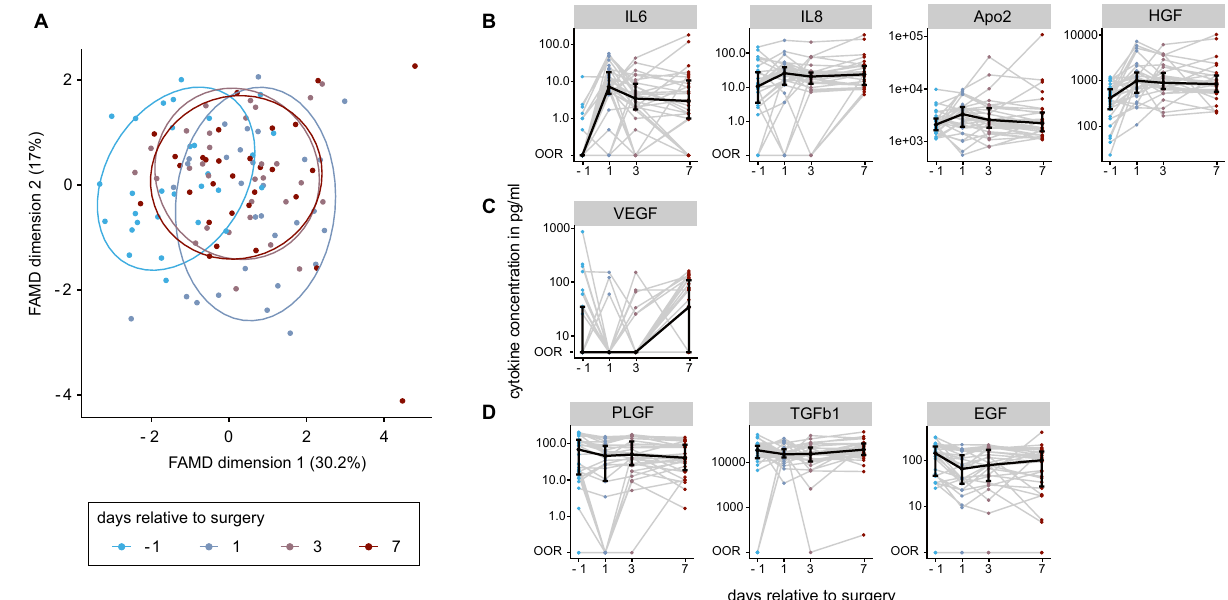
Figure 2. Cytokine and growth factor levels vary before and after surgery. ( A ) Factor analysis for mixed data on cytokine and growth factor data. The first dimension explains 30.2% of the variance and separates preoperative time point (day -1) from postoperative time points. 80% confidence intervals are drawn per time point. Every point represents one patient for one time point. ( B ) Time course of cytokines and growth factors relative to surgery showing increasing concentrations. ( C ) Time course of VEGF showing concentrations below the detection limit until POD7. ( D ) Time course of cytokines and growth factors with a slight decrease. Median and IQR (25% and 75% quantiles) are indicated in black. Each patient is connected by one grey line over the time points. OOR depicts out of range